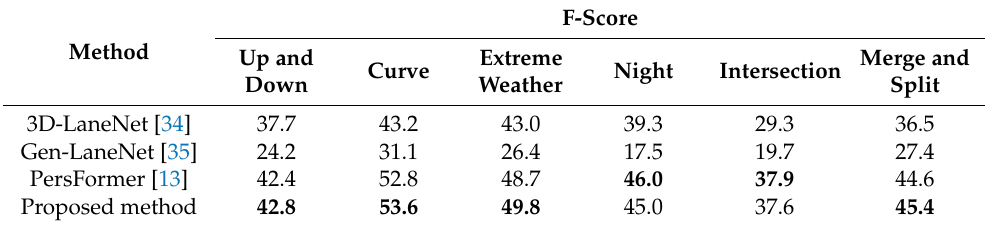
Table 3. The comparison results in accuracy measure. Proposed method achieves the best F-score on 4/6 scenario sets. The best scores are marked in bold.